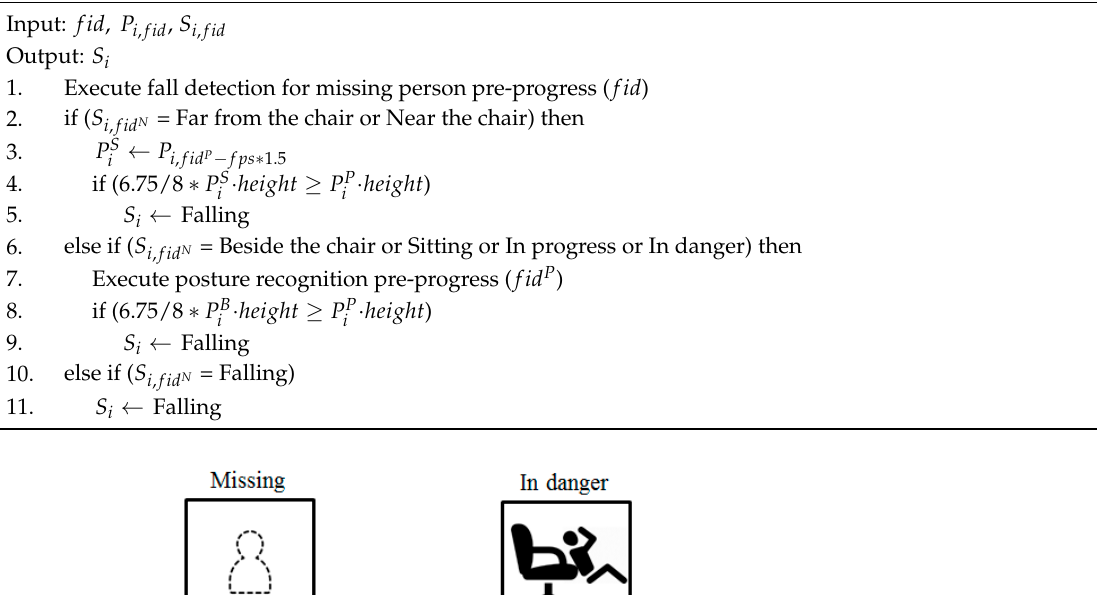
Algorithm 10 Fall detection for missing person